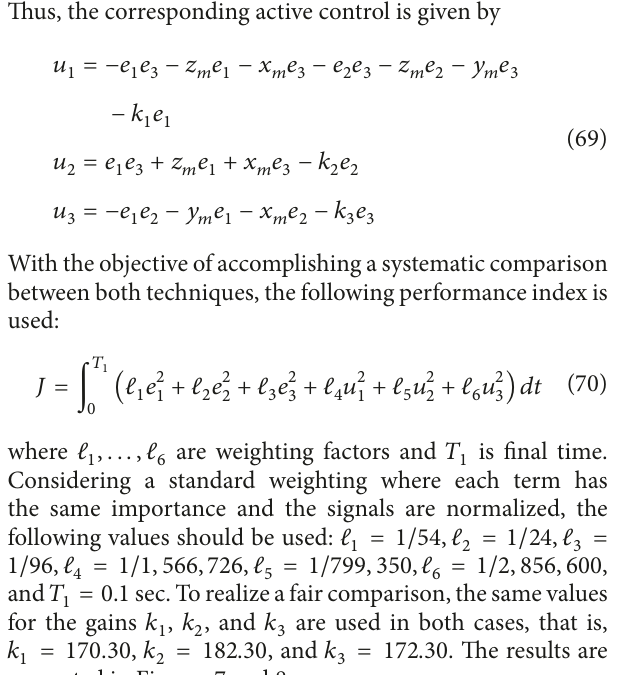
−2.5−2−1.5−1−0.500.5 Figure4:Synchronizationprocessbetweenslavestate 𝑦 𝑠 andmaster state 𝑦 𝑚 .